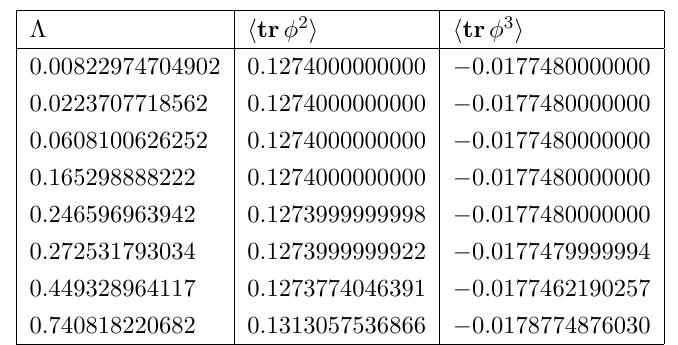
Table 1 . The values a 1 , a 2 obtained through numerical integration of the di(cid:11)erential equation (3.4) with initial conditions (5.1) for p 1 = 0 : 12, p 2 = 0 : 28.